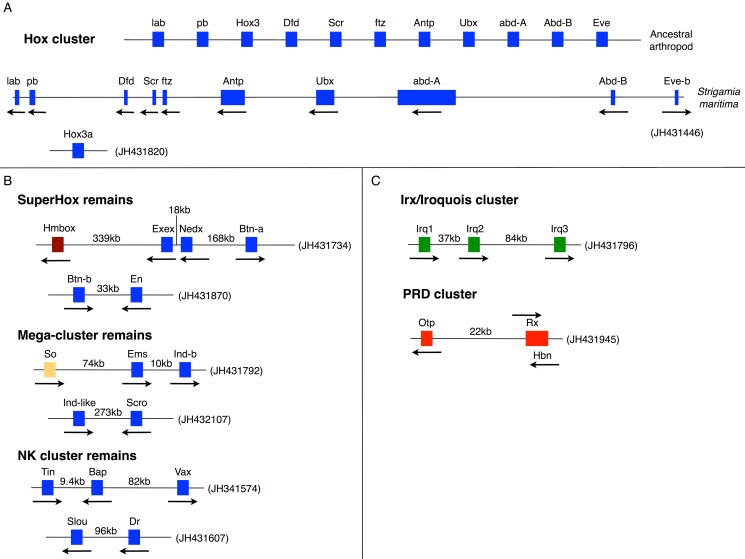
Homeobox gene clusters.(A) The Hox gene cluster of S. maritima compared to the cluster that can be deduced for the ancestral arthropod. S. maritima provides the first instance of an arthropod Hox cluster with tight linkage of an Even-skipped (Eve) gene (see text). Hox3 is the only gene missing from the S. maritima Hox cluster, but may be present elsewhere in the genome on a separate scaffold (see main text and Text S1 for details). The S. maritima cluster is drawn approximately to scale and spans 457 kb from the start codon of labial (lab) to the start codon of Eve-b. Arrows denote the transcriptional orientation. (B) Remains of clustering and linkage of ANTP class genes in S. maritima. The blue boxes are genes belonging to the ANTP class. The brown box is a gene belonging to the HNF class. The orange box is a gene belonging to the SINE class. The intergenic distances are indicated in kb. (C) Clusters of non-ANTP class homeobox genes in S. maritima. The green boxes are genes belonging to the TALE class. The red boxes are genes belonging to the PRD class. The intergenic distances are indicated in kb, except in the case of Rx-Hbn as these genes are overlapping but with opposite transcriptional orientations. All scaffold numbers are indicated in brackets.